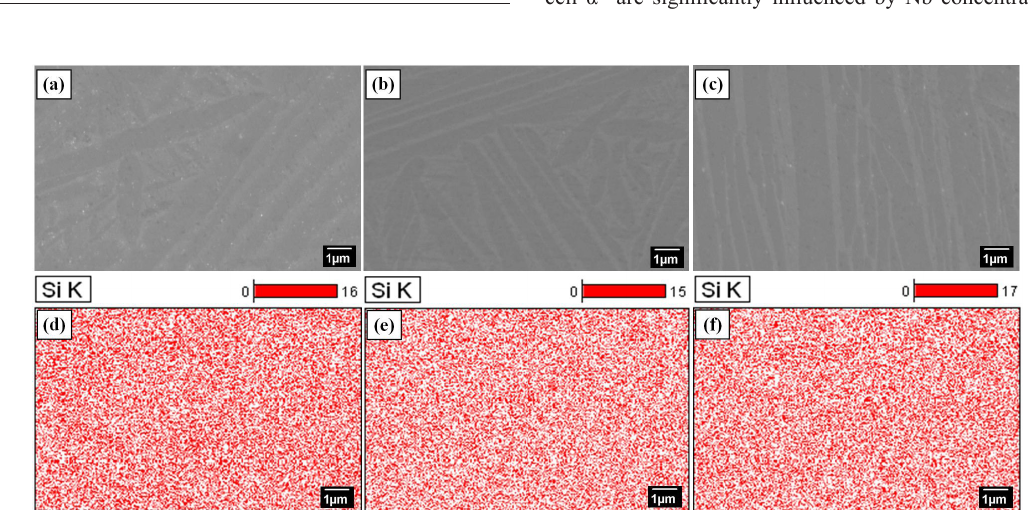
Figure 4. SEM/SEI images of FC Ti-15Nb-xSi samples with x = 0.15 (a), x = 0.35 (b) and x = 0.55Si (c) and EDS mapping of Si (d-f),